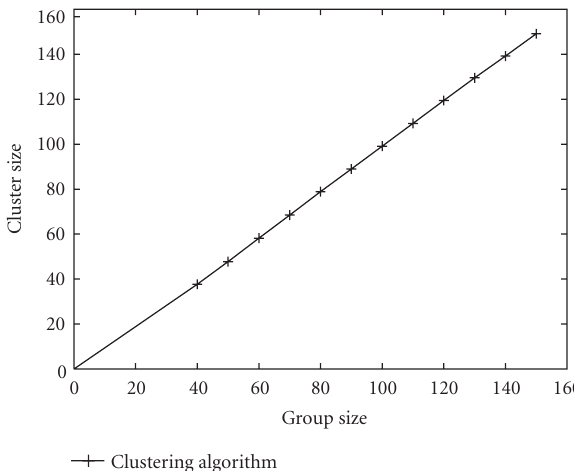
Figure 5: The e ff ect of the average number of queries on the cluster size.